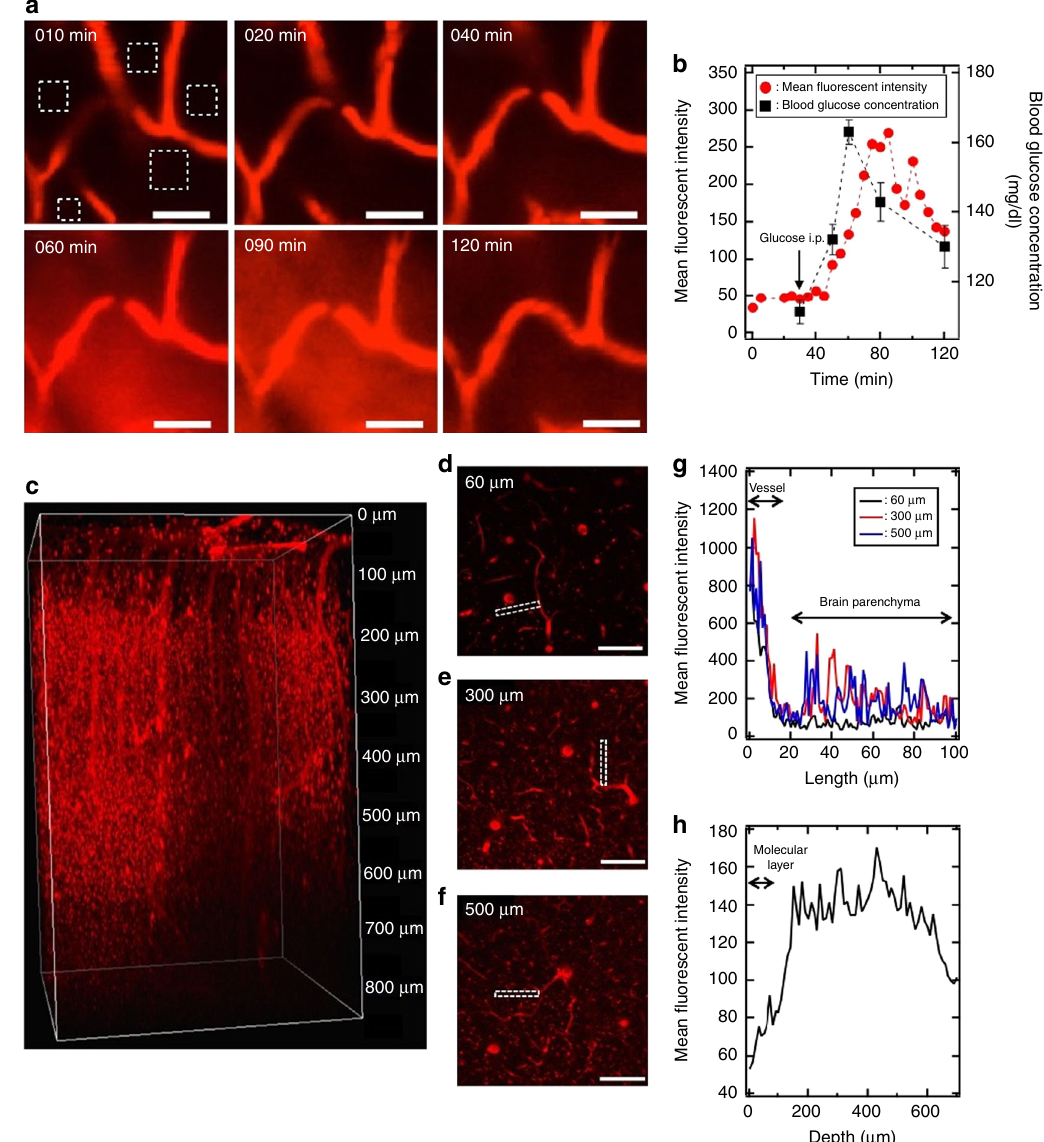
Fig. 3 Real-time observation of the 25%Gluc(6)/m crossing the BBB. a Sequential images of mouse cerebrum observed using IVRT-CLSM. The 25%Gluc (6)/m (red) were intravenously injected to a mouse after a 24-h fast, followed by an intraperitoneal injection of 20 wt% glucose 30 min later. The scale bars indicate 50 μ m. b Time course of blood glucose concentration (black squares) and the mean fl uorescent intensities of the 25%Gluc(6)/m (red circles) in the region of interest (ROI) of the brain parenchyma indicated as white rectangles in a . The arrow indicates the time of intraperitoneal injection of the 20 wt% glucose. Blood glucose concentrations were expressed as the mean ± SEM. c Images of Gluc(6)/m (red) in the mouse cerebrum observed using intravital multiphoton microscopy 48 h after administration. Cross-sections at depths of 60 μ m ( d ), 300 μ m ( e ) and 500 μ m ( f ) are also shown. The scale bars indicate 100 μ m. g Distribution pro fi les of Gluc(6)/m from blood vessels to the brain parenchyma in the selected region (indicated by a white rectangle in d , e , f ) at depths of 60 μ m (black line), 300 μ m (red line) and 500 μ m (blue line). h Depth pro fi les of the mean fl uorescent intensities from 0 to 700 μ m in the brain parenchymal